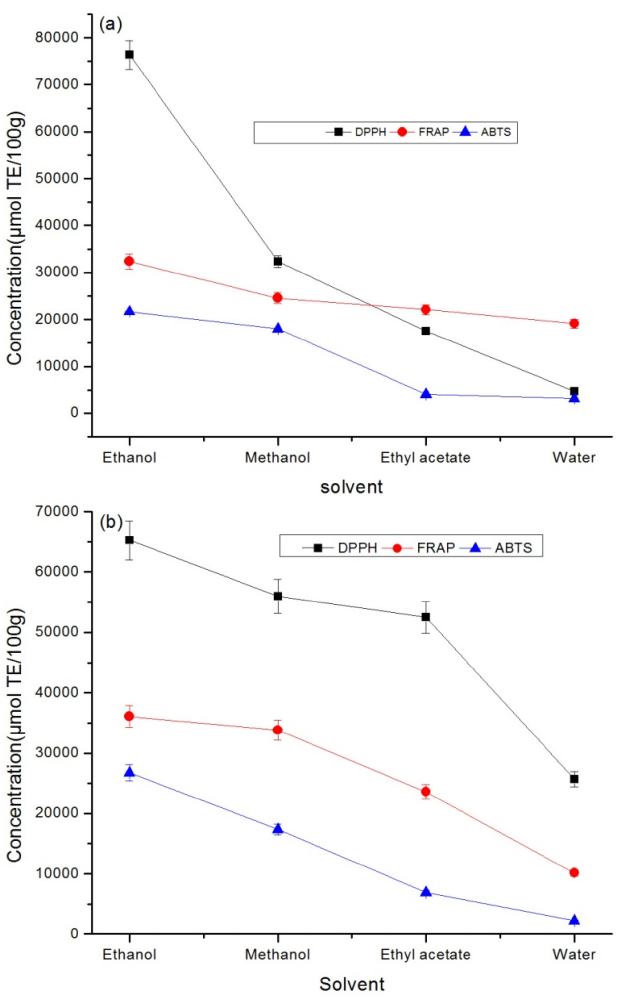
FIGURE 1 - DPPH, FRAP and ABTS from various solvent extracts of leaves (a) and stem bark (b) from Anisophyllea laurina R. Br. ex